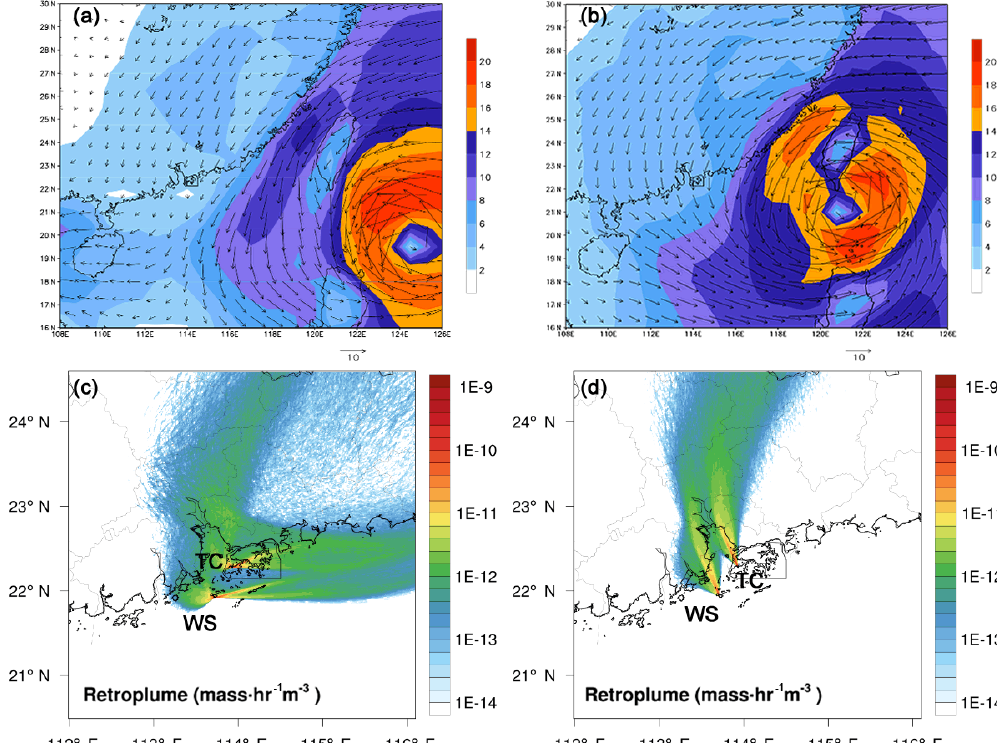
Figure 3. Model-simulated 10m wind vectors (arrows) and wind speed (shaded, unit: ms − 1 ), as well as the distribution of air mass concen- trations (unit: massh − 1 m − 3 ) at the 100m height level simulated by HYSPLIT Lagrangian backward particle release model with WS and TC as the starting points 2 days (20 September 2013) before (a, c) and 1 day (21 September 2013) before (b, d) the arrival of